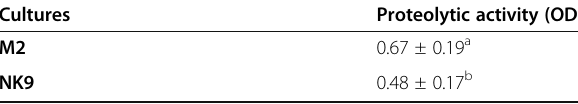
Table 3 Proteolytic activity of the soy milk fermented with